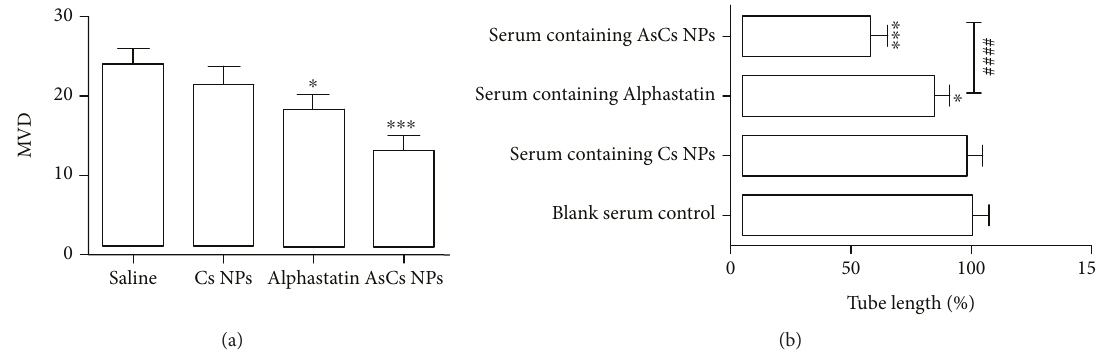
Figure 7: The inhibitory e ff ect on angiogenesis by di ff erent nanoparticles. (a) Microvessel density expression in tumor from LA975 tumor-bearing mice treated with di ff erent nanoparticles. ∗ P < 0 05 and ∗∗∗ P < 0 001 versus saline group. (b) The inhibitory e ff ect of mouse serums containing drugs against HUVEC tube formation. ∗ P < 0 05 and ∗∗∗ P < 0 001 versus blank serum control, ### P < 0 001 versus serums containing